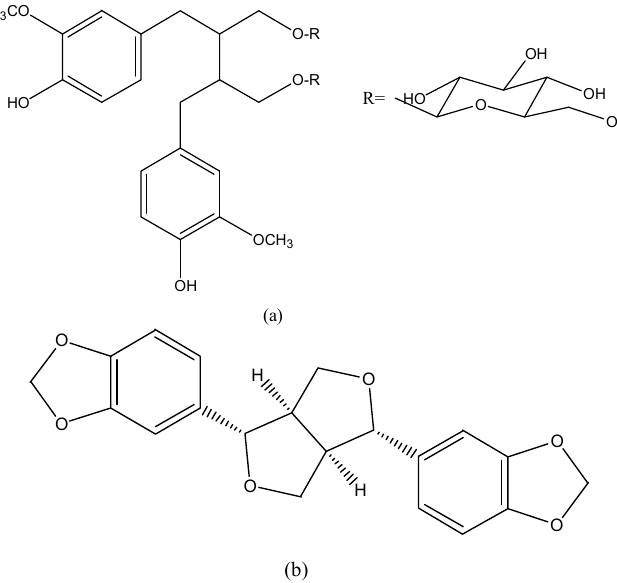
Figure 9. The chemical structures of ( a ) Secoisolariciresinol diglucoside and ( b ) sesamin.